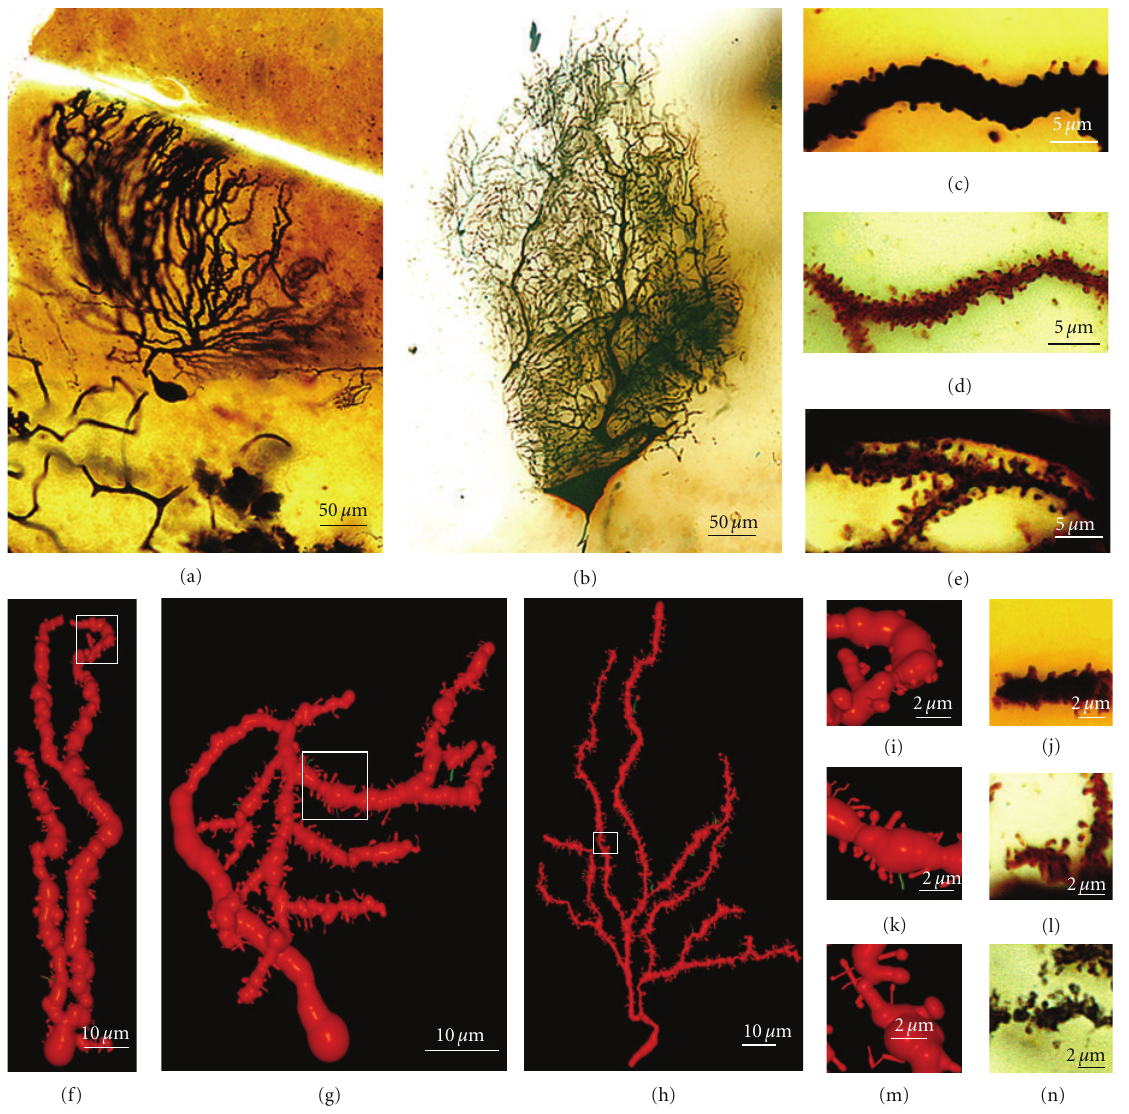
Figure 12: (a) Depicts a Purkinje cell, “adult bird” according to the label of the Cajal histological preparation, Golgi method. (b) Purkinje cell of “adult man” according to the label of the Cajal histological preparation, Golgi method. (c) Golgi-impregnated dendritic spines of the Purkinje cell of “adult bird.” (d) Golgi-impregnated dendritic spines of the Purkinje cell of “adult cat.” (e) Golgi-impregnated dendritic spines of the Purkinje cell of “adult man.” (f) Three-dimensional reconstruction of a portion of the dendritic tree of the “adult bird” (a). (g) Three-dimensional reconstruction of a portion of the dendritic tree of the “adult cat.” (h) Three-dimensional reconstruction of a portion of the dendritic tree of the “adult human.” (i) Boxed region in (f) showing sessile dendritic spines. (j) Golgi-impregnated sessile spines of “adult bird.” (k) Boxed region in (g) showing pedunculated spines. (l) Golgi-impregnated pedunculated spines of “adult cat.” (m) Boxed region in (h) showing pedunculated spines. (n) Golgi-impregnated pedunculated spines of “adult human.” Filopodia are color coded in